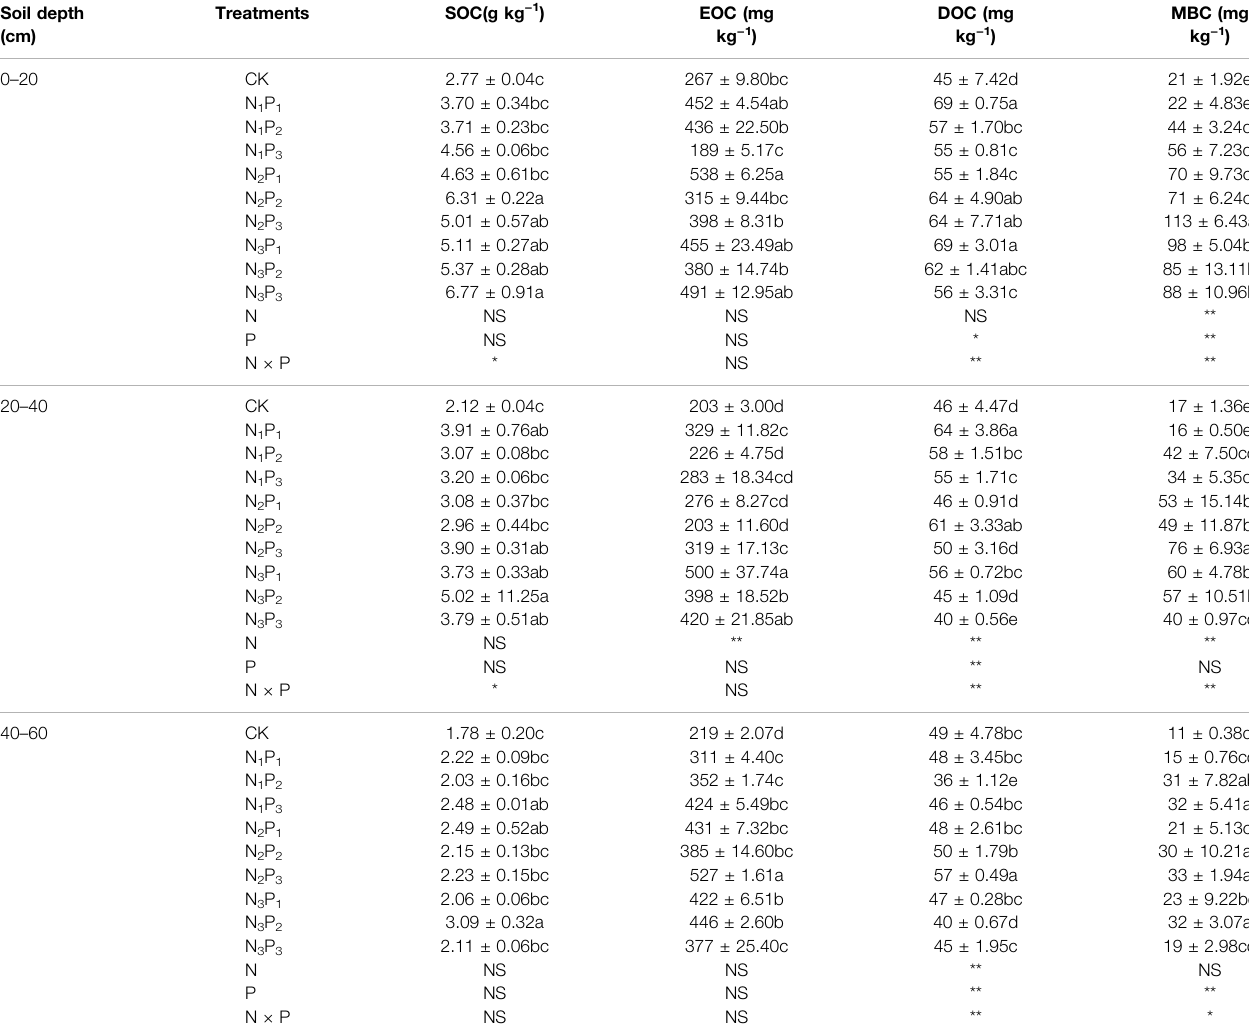
TABLE 2 | Soil organic carbon contents and labile fractions under different treatments. Soil depth (cm)